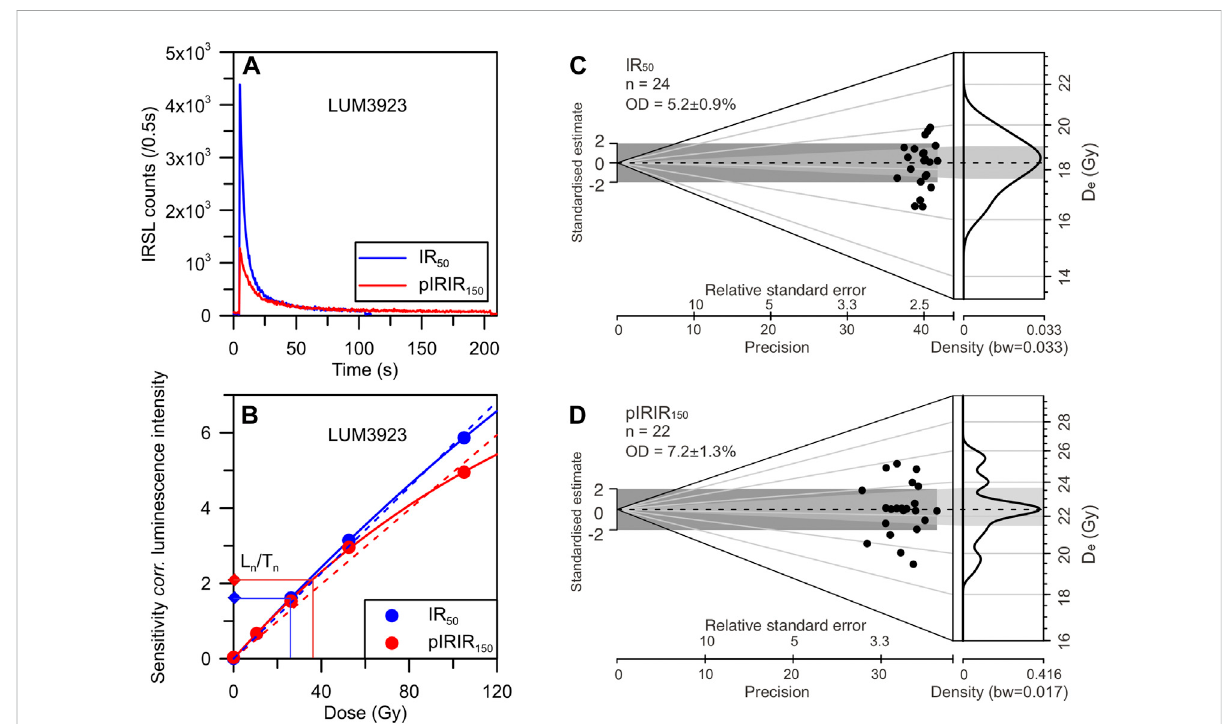
FIGURE 2 Decaycurves (A) ,dose-responsecurves (B), and D e distributionfortheIR 50 (C) andpIRIR 150 (D) signalsforonerepresentativesampleLUM3923. The dose-response curve was fi tted using a linear (dashed line) and one saturating exponential (dashed line) equation in Figure 2B,